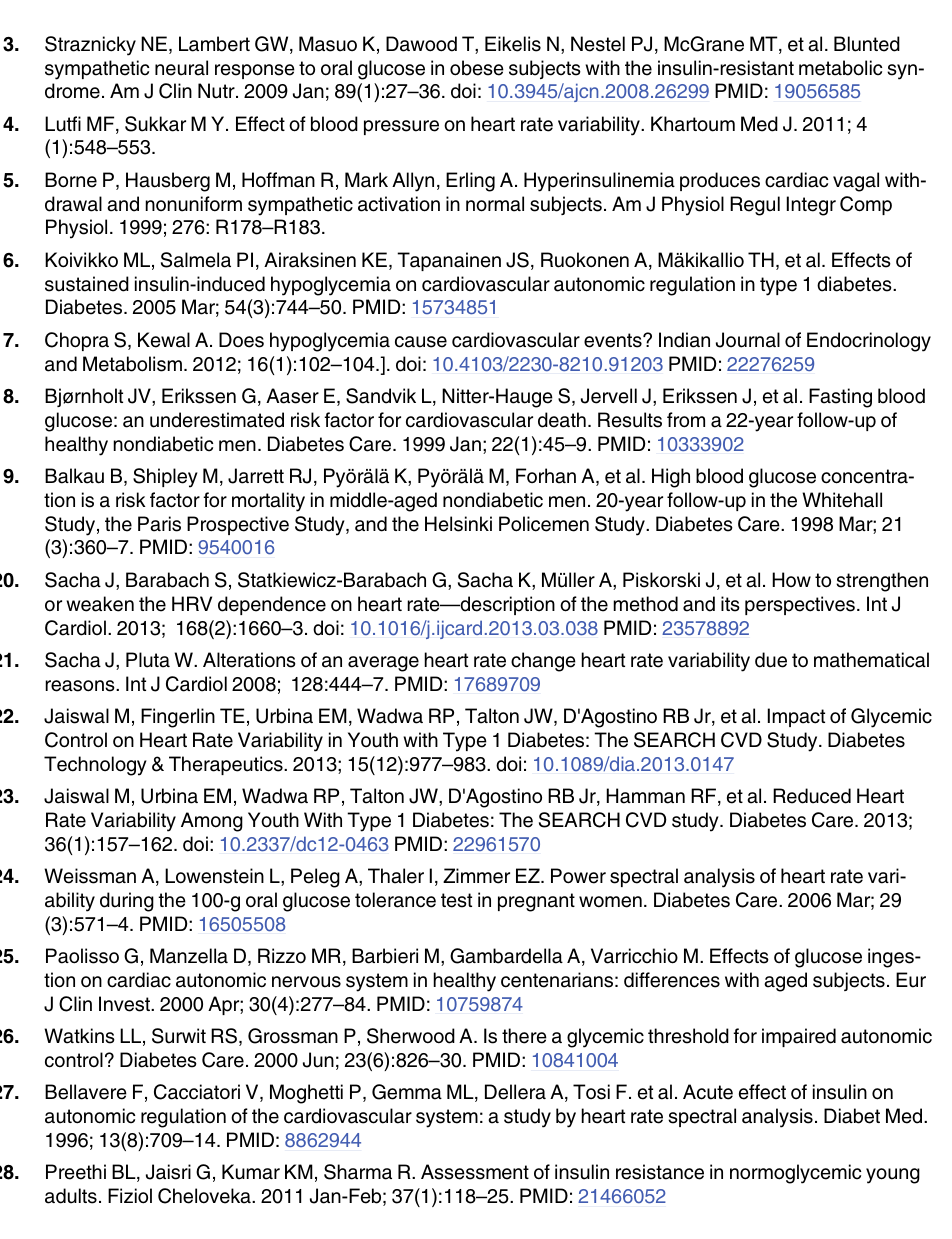
PLOS ONE | DOI:10.1371/journal.pone.0159820 July 21,